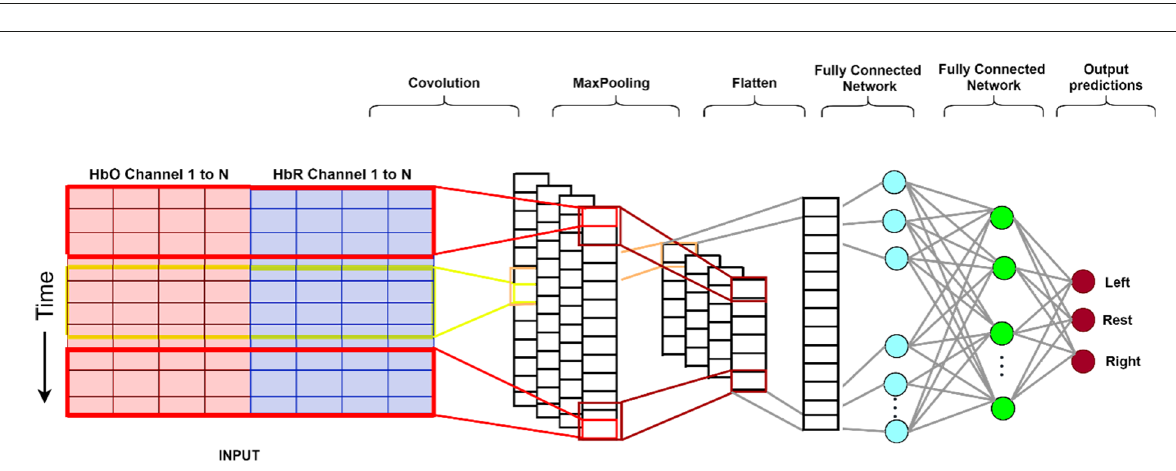
FIGURE6 The structure of the CNN used in this study. From the input data (left), the convolutional (encoding) layers extract feature maps. Subsequently, these feature maps are resampled (max-pooling) to a coarser resolution before flattening to a 1-dimensional array. This is then passed on to the first fully connected network which applies weights to predict the correct label. Lastly, the final output layer computes and presents probabilities for each label (Gratton et al., 2006). CNN, convolutional neural